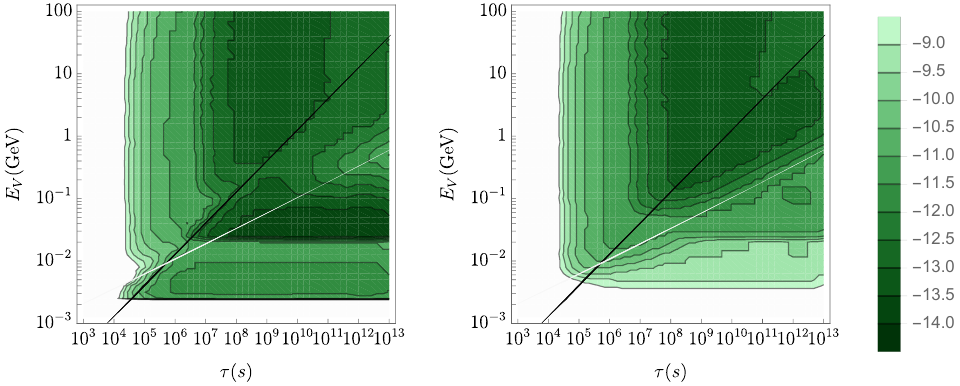
Figure 7 . BBN upper limits on the product log ( m V Y V = GeV) as a function of lifetime (cid:28) V and 10 injection energy E V = m V = 2 for decays V ! (cid:13)(cid:13) (left) and V ! e + e (cid:0) (right). The black and white lines superimposed on these plots show key thresholds for the 4P (black) and IC (white) processes discussed in the